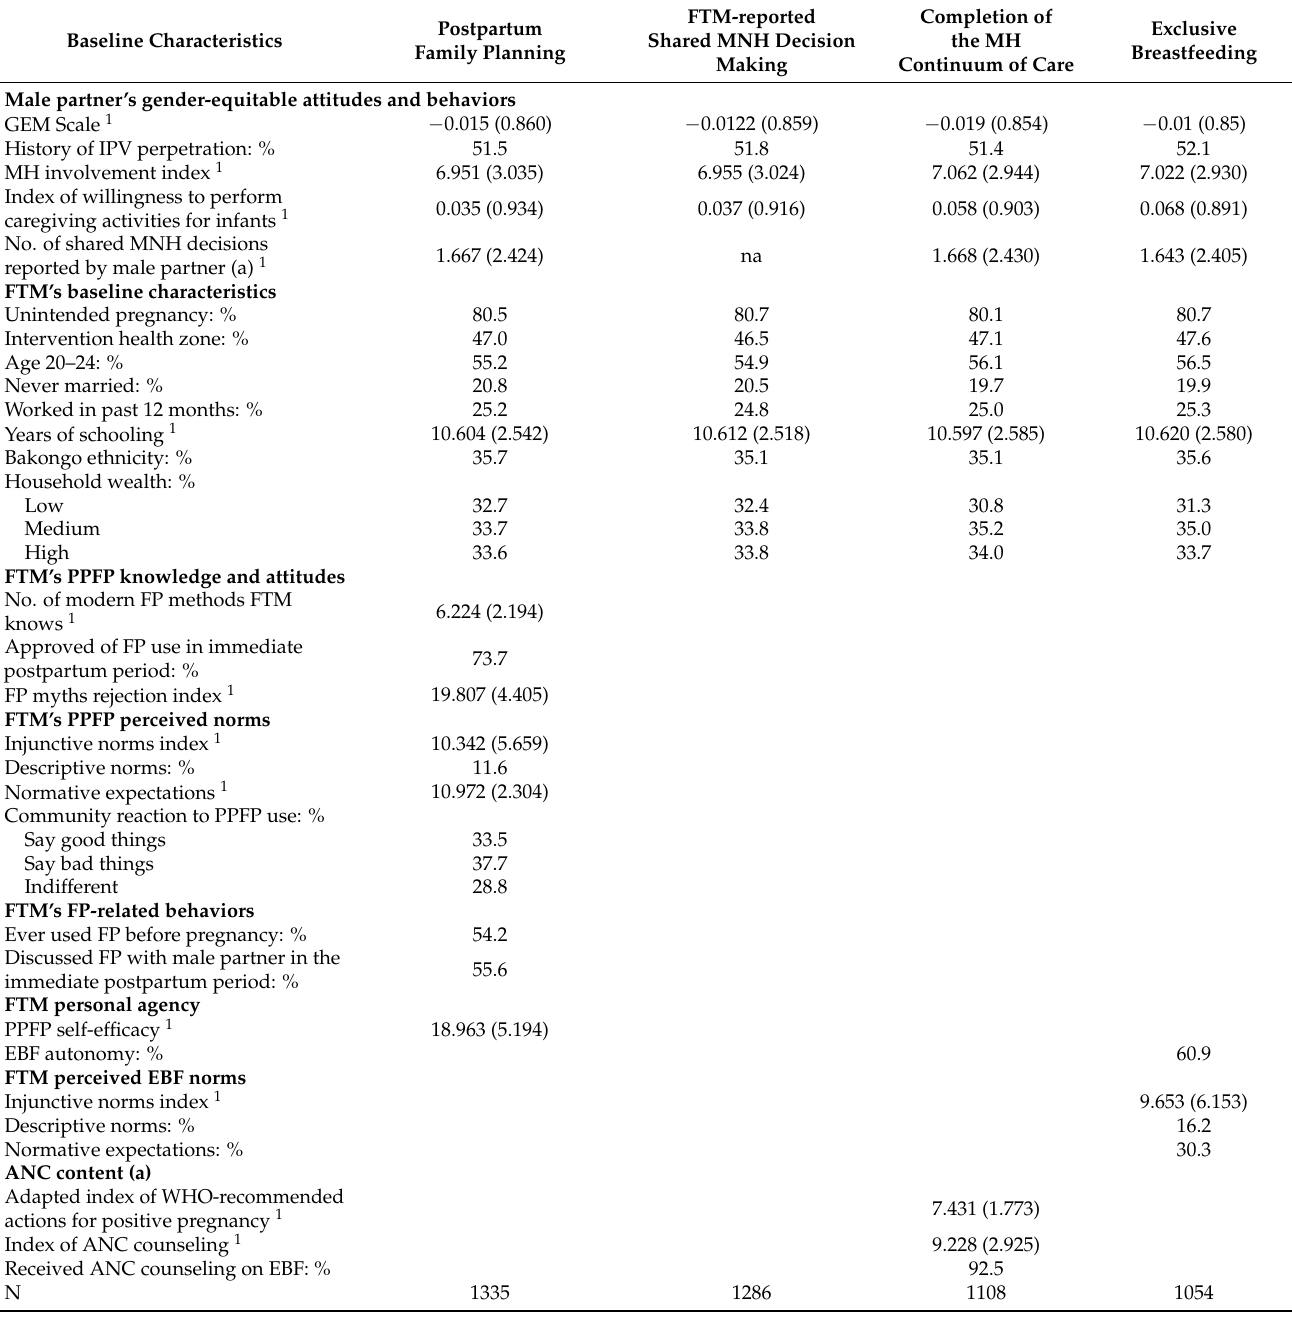
Table 1. Characteristics of the sample by outcome examined, first-time mothers age 15–24, Kinshasa,